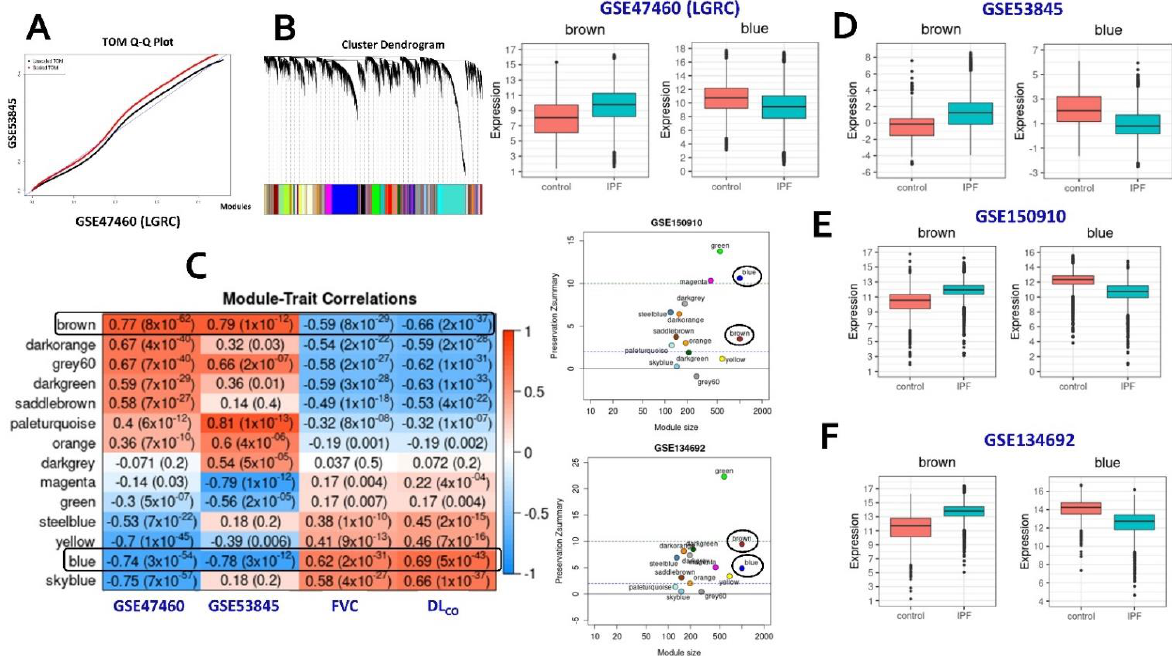
Figure 1. Consensus WGCNA steps. ( A ) Q – Q plot of the scaled TOM matrices of both the training cohorts. ( B ) Hierarchical dendrogram constructed based on the consensus TOM matrix. ( C ) Correlation heatmap of consensus modules with the phenotypic traits from both training datasets. Candidate modules identified based on the correlation strength with phenotype status in both cohorts (GSE47460 or LGRC; GSE53845) and the lung-function traits (FVC and DL CO ) from the LGRC cohort. Only modules with a disease (IPF) correlation ≥ 0.5 in either of the two training cohorts have been included in the heatmap. ( D ) Box plots illustrating the expression levels of intramodular hubs from the two candidate modules (brown and blue) in the two cohorts. ( E , F ) Scatter plots of module preservation scores of consensus modules (on the left) and box plots of expression levels of the brown and the blue modules (on the right) in two independent validation cohorts, namely, GSE150910 (Panel E ) and GSE134692 (Panel F ).